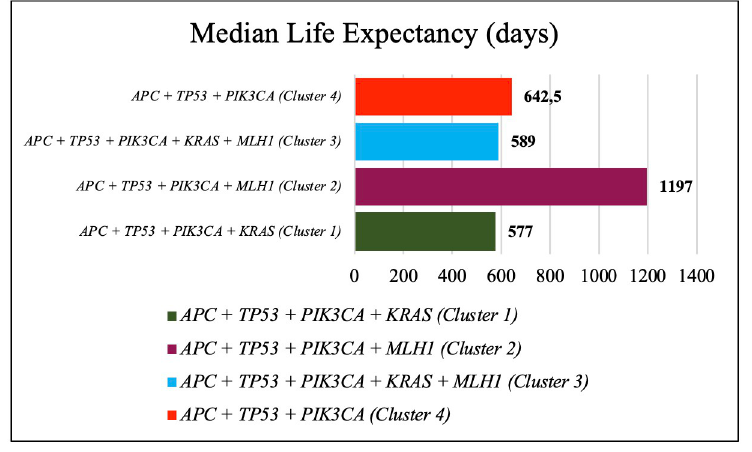
Fig 1. Median life expectancy in days.